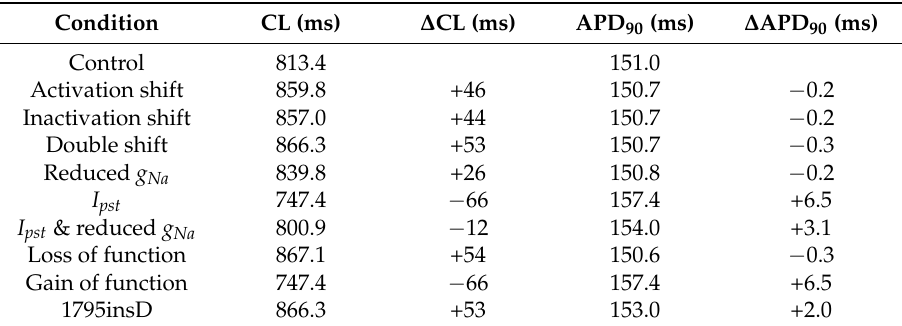
Table 2. Effects on action potential